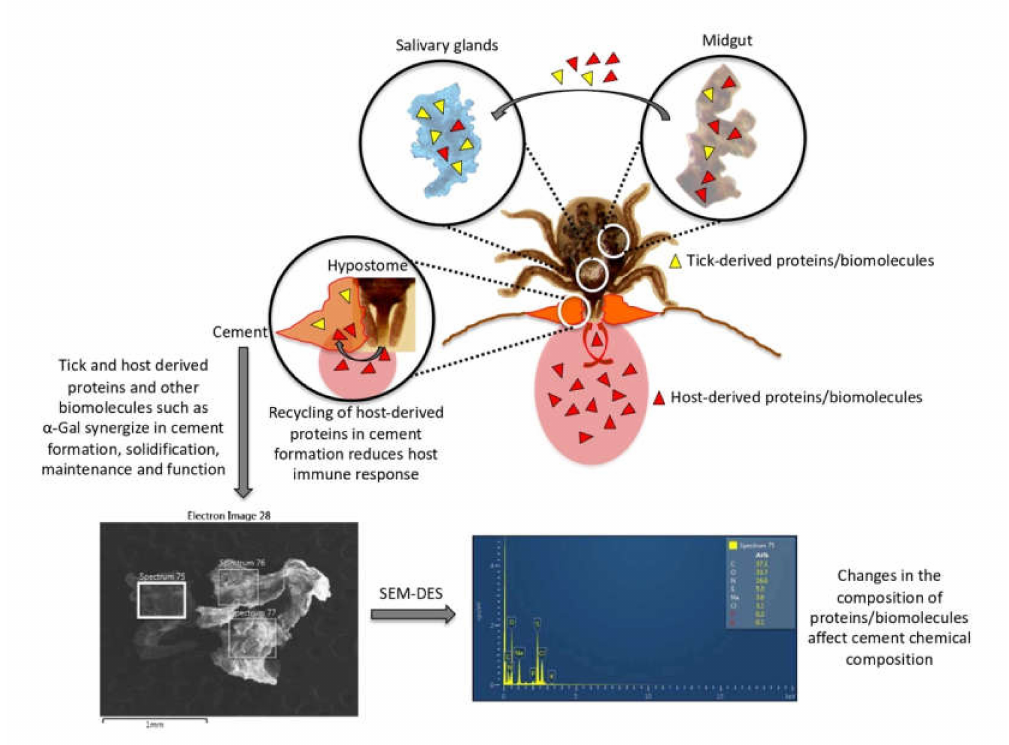
Figure9. Thecombinationoftickandhostderivedproteinsinthecementomeresultedinanevolutionary adaptation to long-lasting ectoparasitic blood feeding. Our hypothesis is that ticks evolved to combine tick and host derived proteins and other biomolecules such as α -Gal to synergize in cement formation, solidification, and maintenance to facilitate attachment, feeding, interference with host immune response, and detachment. Changes in the composition of proteins / biomolecules a ff ect cement chemical composition. In addition to the role of cementome proteins in the inhibition / interference with host immune response, the recycling of host-derived proteins in cement formation reduces host immune response as these proteins are recognized as self-antigens. Representative images of SEM–EDS analysis are shown, and all results are displayed in Data S5.